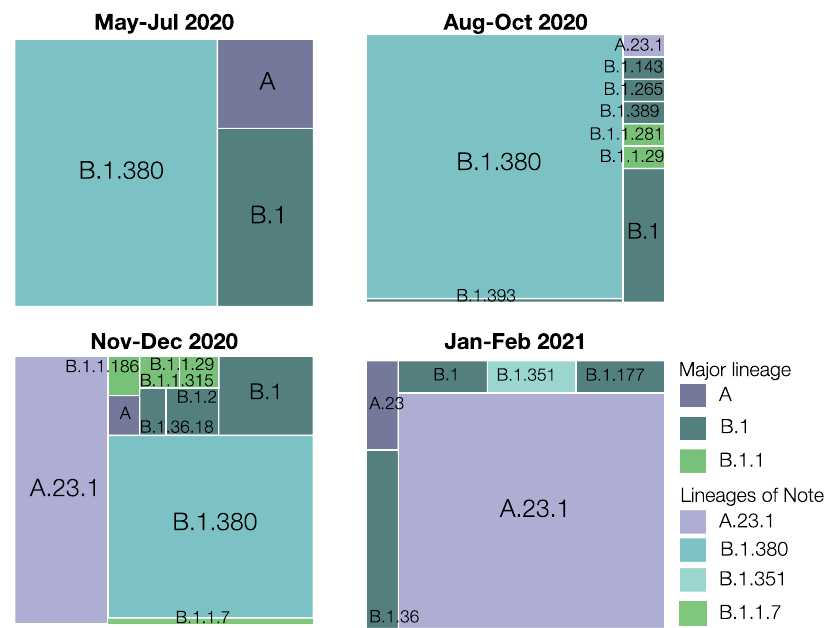
Fig. 4 Lineage diversity sampled in Rwanda across four time points: May – Jul 2020 ( n = 28), Aug – Oct 2020 ( n = 86), Nov – Dec 2020 ( n = 74), Jan – Feb 2021 ( n = 28). Lineage B.1.380, a Rwanda-speci fi c lineage, dominated the sampled diversity during the fi rst wave. Lineage A.23.1 fi rst appeared in Rwanda in October 2020, and quickly attained a signi fi cant proportion of the sampled SARS-CoV-2 genome sequences. More recently, we detected and sequenced single cases of the B.1.1.7 and B.1.351 VOCs, associated with incoming travelers from Burundi and the Democratic Republic of the Congo, respectively. n : number of positive SARS-CoV-2 samples